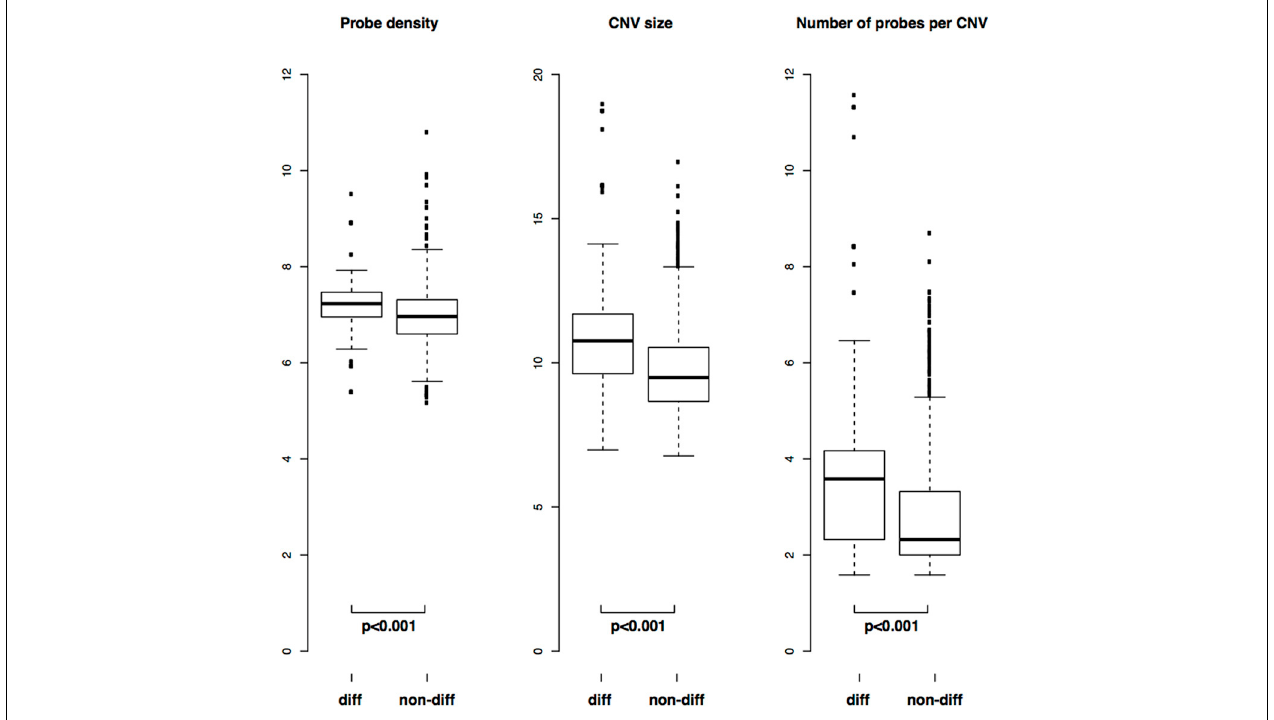
FIGURE 3 | Comparison of distributions of CNV length, number of probes and probe density in differentiating (“diff”) vs. non-differentiating (“non-diff”) CNVs. P -values from two-sample Kolmogorov-Smirnov test.